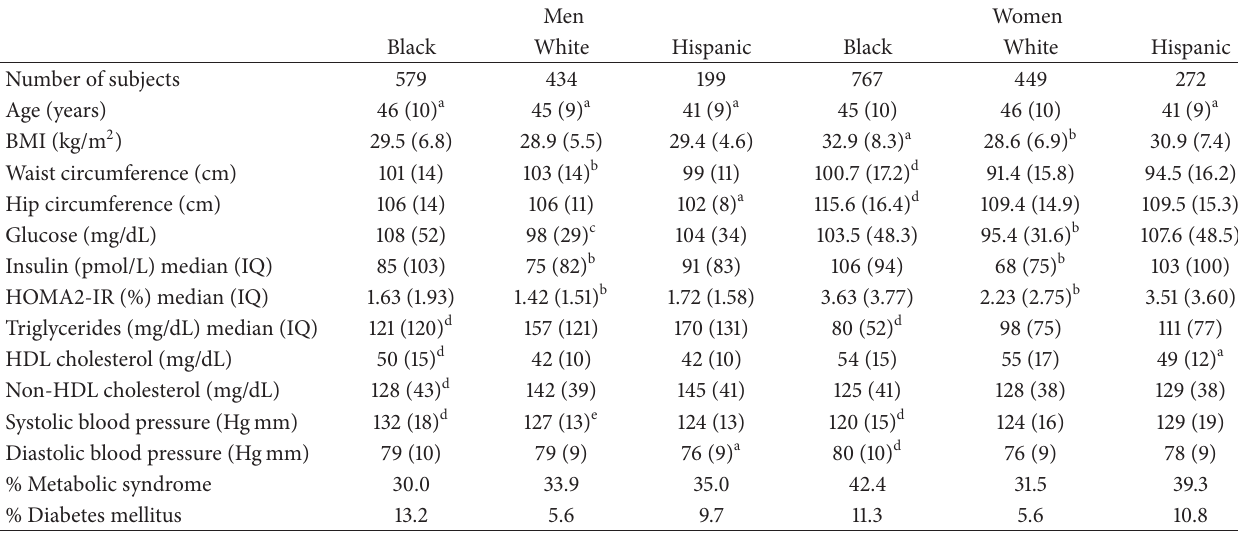
Table 1: Subject